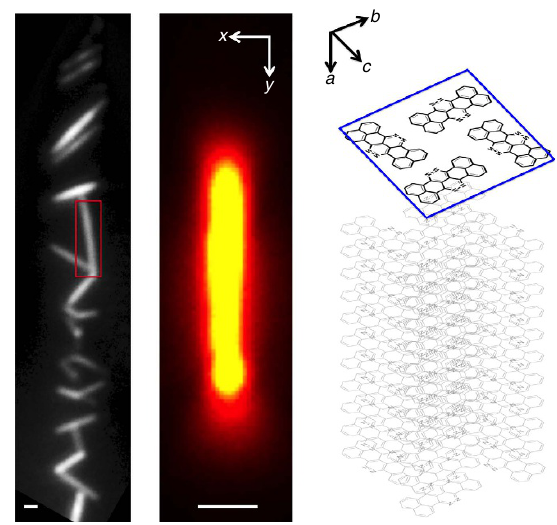
Figure 1 | Orientation and structural schematic of TATnanowire crystals. (Left) Photoluminescence (PL) of TAT nanowire crystals formed from solution-phase self assembly. (Center) PL image of isolated TAT nanowire with p -stacking direction oriented along laboratory Y axis. (Right) Structural schematic of TAT nanowire crystal showing relative orientation of crystallographic axes { a , b , c } with respect to laboratory X – Y plane. Scale bar,